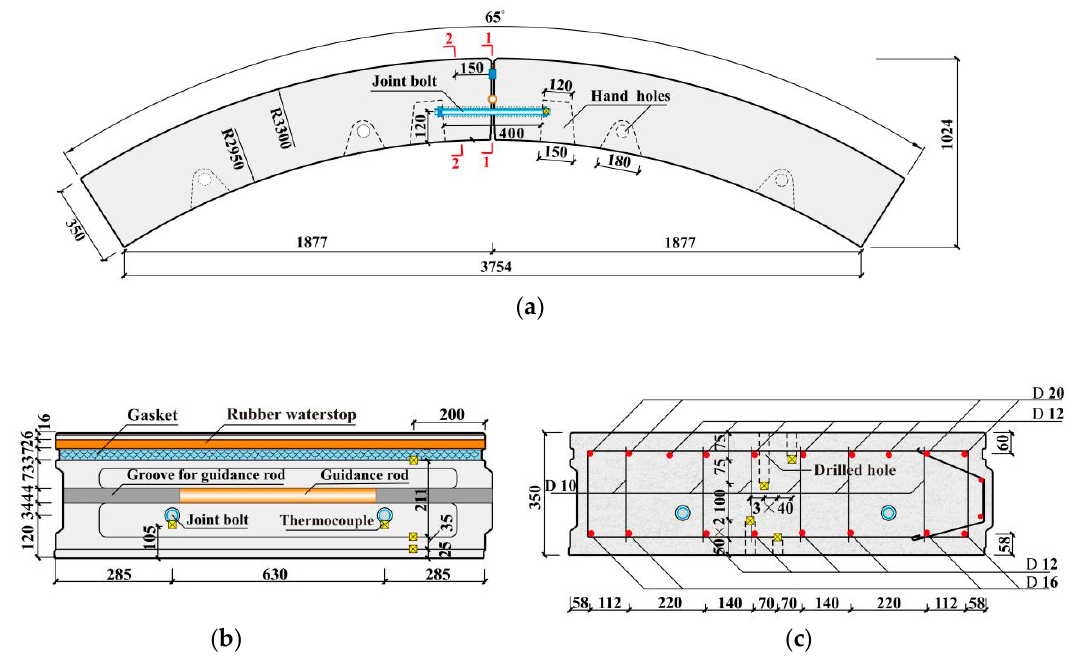
Figure 1. Schematic diagrams and reinforcement details of segmental joint specimen (unit: mm). ( a ) Elevation view; ( b ) section 1-1; ( c ) section 2-2.